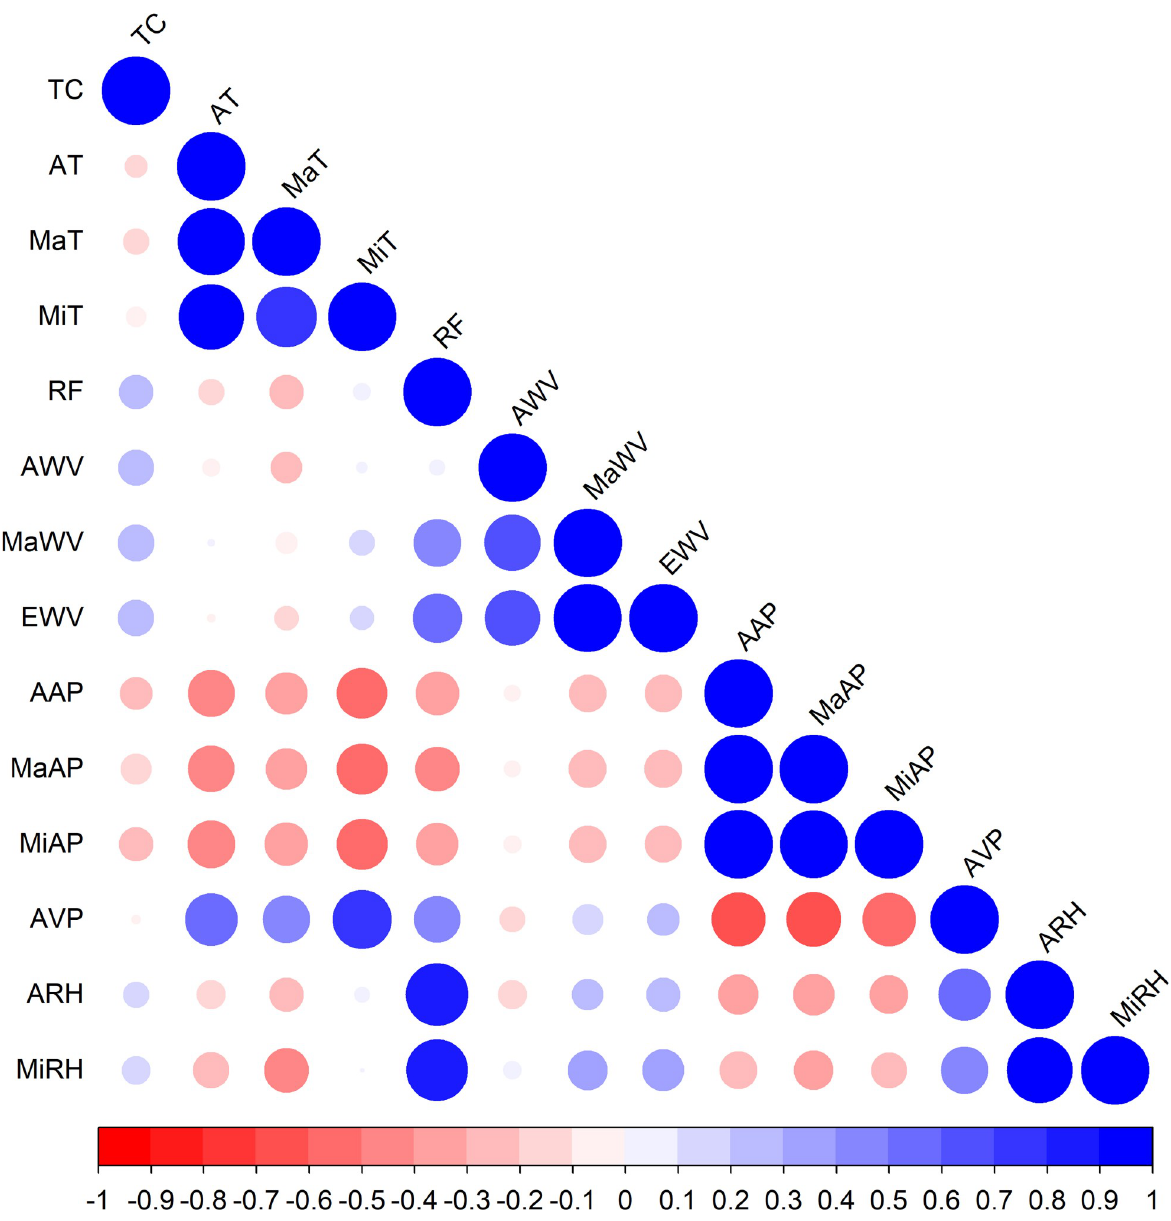
Fig 2. Correlation of tropical cyclone intensities and meteorological variables. TC: tropical cyclone intensities; AT: average temperature; MaT: maximum temperature; MiT: minimum temperature; RF: average precipitation; AWV: average wind velocity; MaWV: maximum wind velocity; EWV: extreme wind velocity; AAP: average air pressure; MaAP: maximum air pressure; MiAP: minimum air pressure; AVP: average vapor pressure; ARH: average relative humidity; MiRH: minimum relative